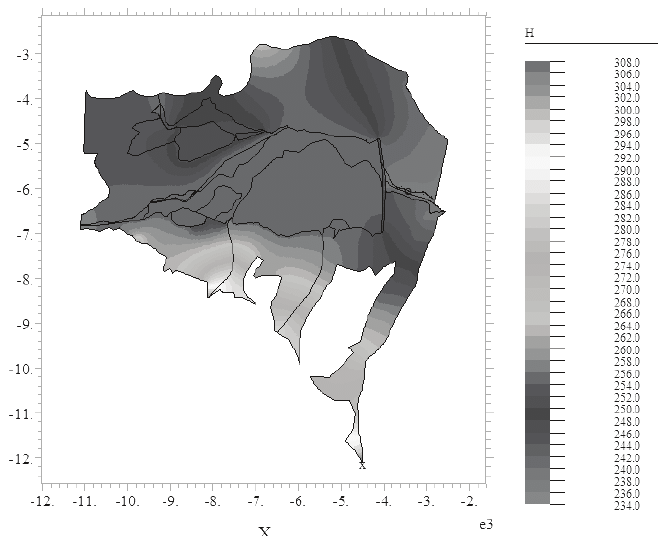
Fig. 9. Water table isohypse